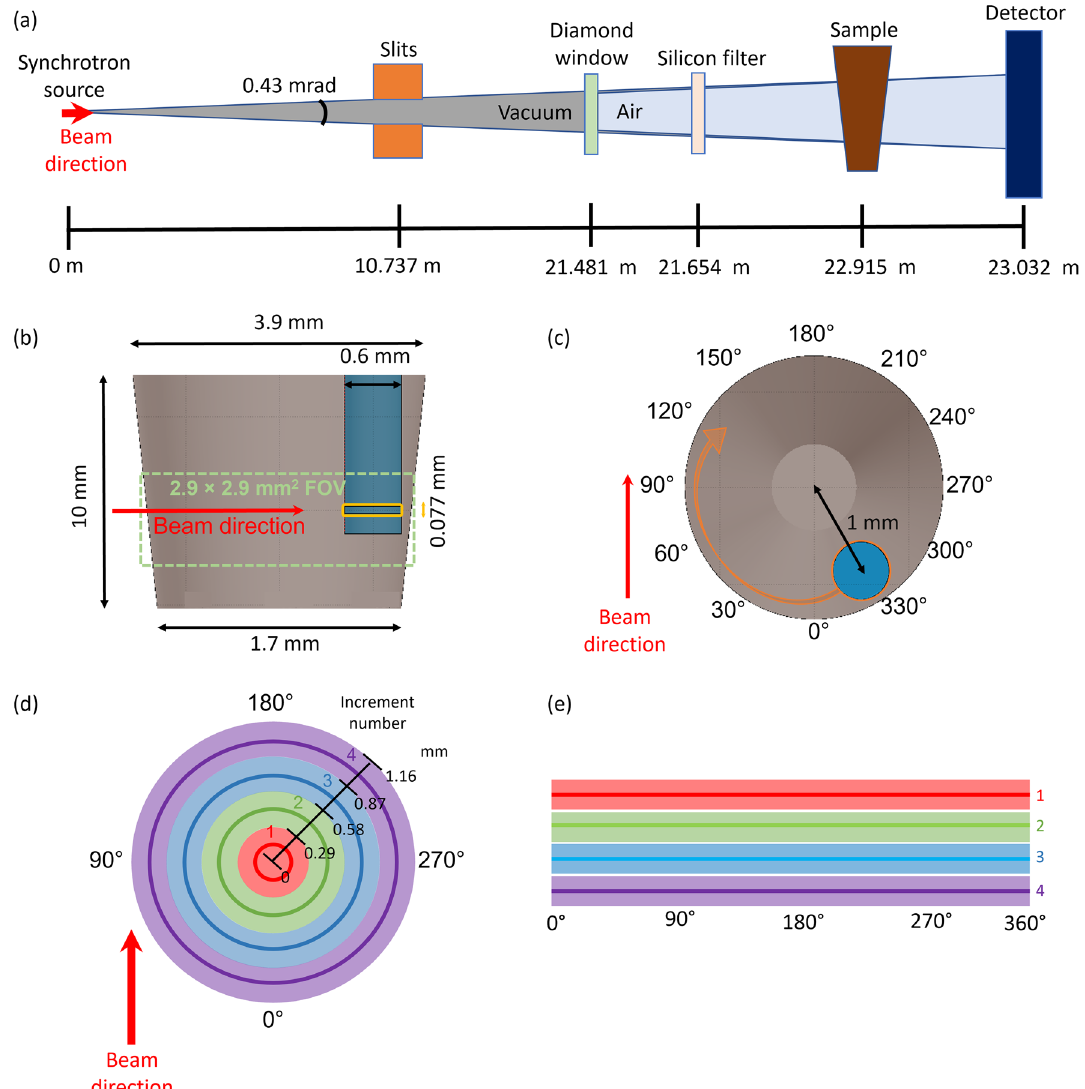
Figure 2. ( a ) Schematics of MOGNO-A beam configuration geometry implemented in computational simulations. Schematics of FLUKA geometry in a ( b ) longitudinal section, where the dashed green box represents the 2.9 × 2.9 mm 2 FOV and the yellow box represents the segment of the root that was illuminated by the beam in the simulations—figure not to scale, and a ( c ) cross section. Cylindrical coordinate representation in FLUKA detector analyses: ( d ) concentric soil cylinder volume increments had 0.29 mm of thickness and ( e ) corresponding region as a function of angle for each